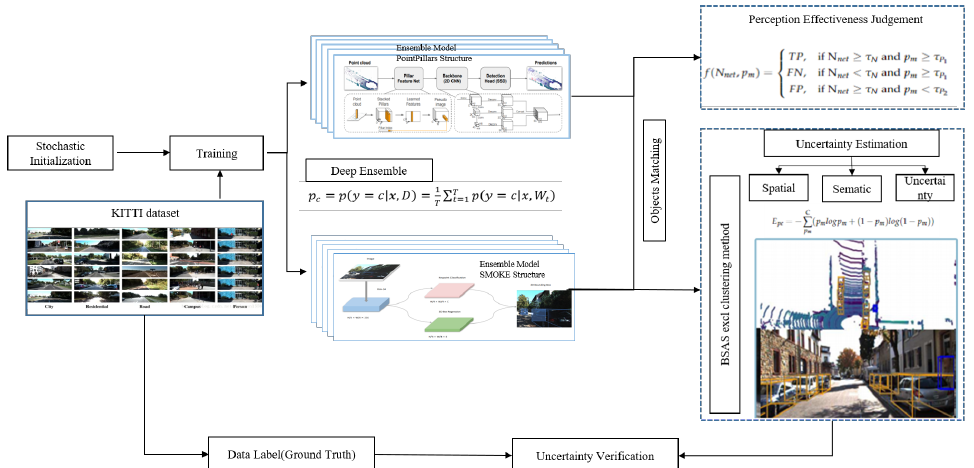
Figure 3. The Schematic sequence of the perception effectiveness judgment and uncertainty evaluation.